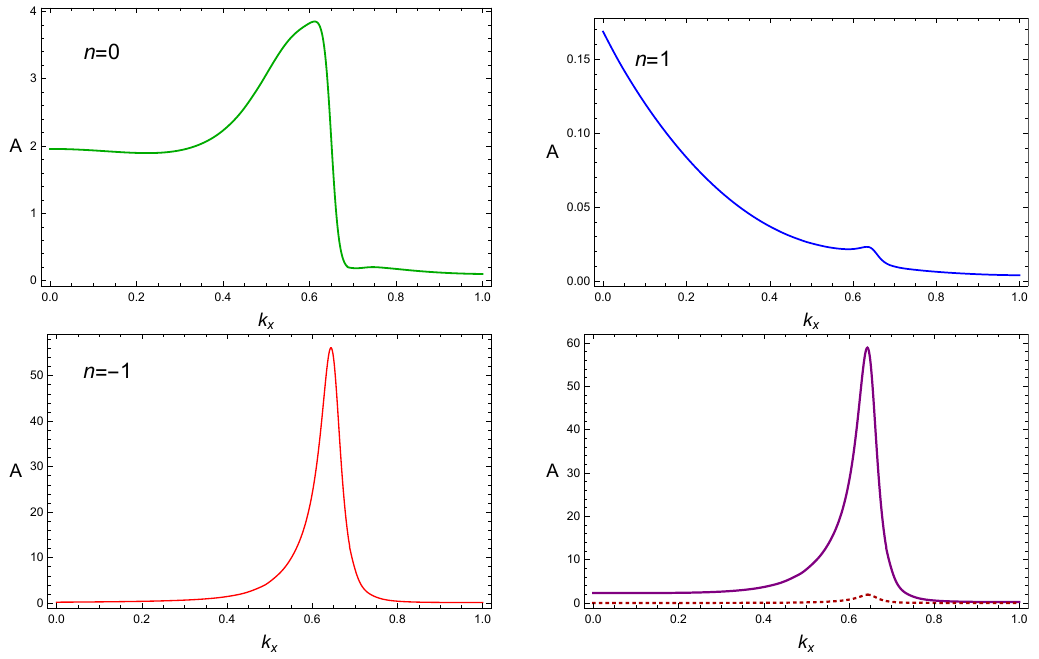
Figure 19 . The contribution to the spectral function for each diagonal component of retarded Green’s functions. The (cid:12)rst three plots correspond to n = 0, n = 1 and n = (cid:0) 1, espectively. They all have a smooth peak near k x = 0 : 65. In the fourth plot the purple curve is the sum of these three modes, while the dotted curve corresponds to the sum of the four higher modes with n = (cid:6) 2 and n = (cid:6) 3. We choose ! = 10 (cid:0) 6 ; k y = 0 and q = 2. The background geometry is the same as